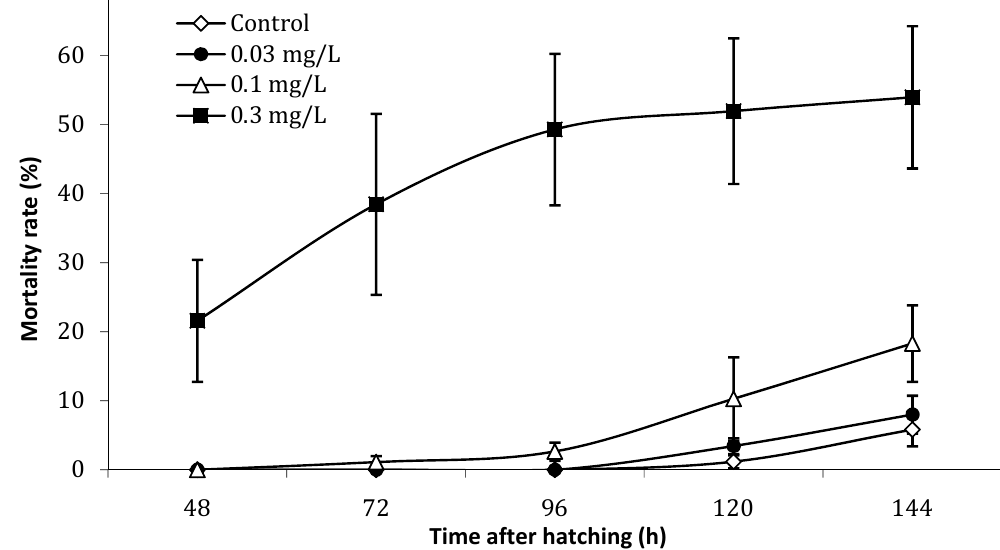
Figure 4. Mortality rate of the zebrafish ( Danio rerio ) larvae during six post-hatching days of pre-exposure to different treatment prepared from a Microcystis aeruginosa natural bloom